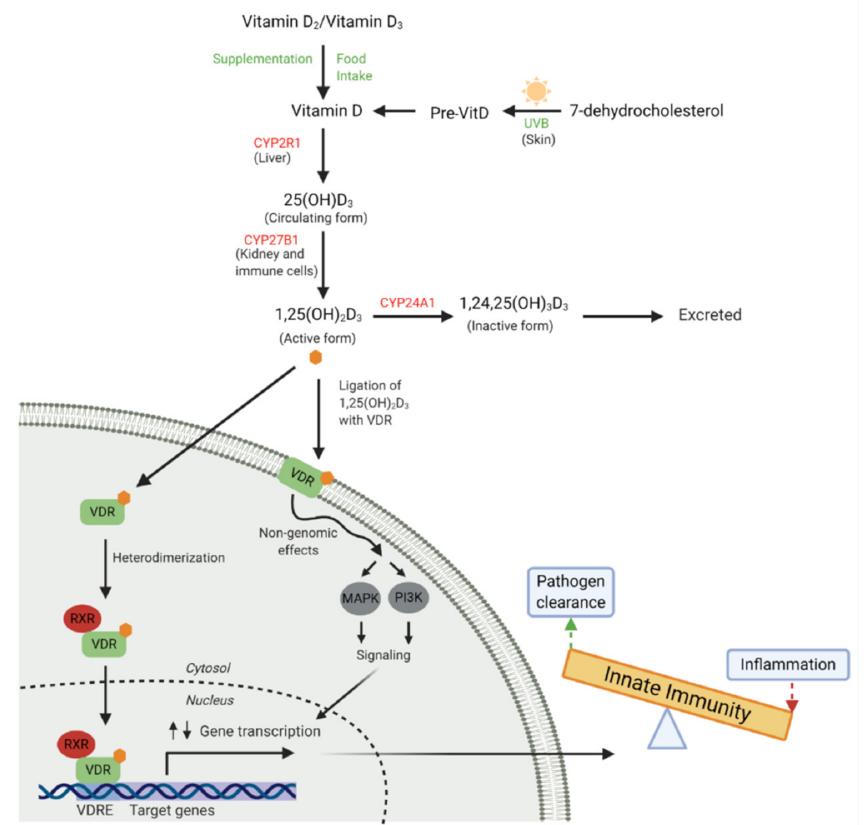
Figure 1. Vitamin D metabolism and receptor binding. Vitamin D is obtained from dietary sources, supplementation or is converted from 7-dehydrocholesterol in the skin by ultraviolet B (UVB)